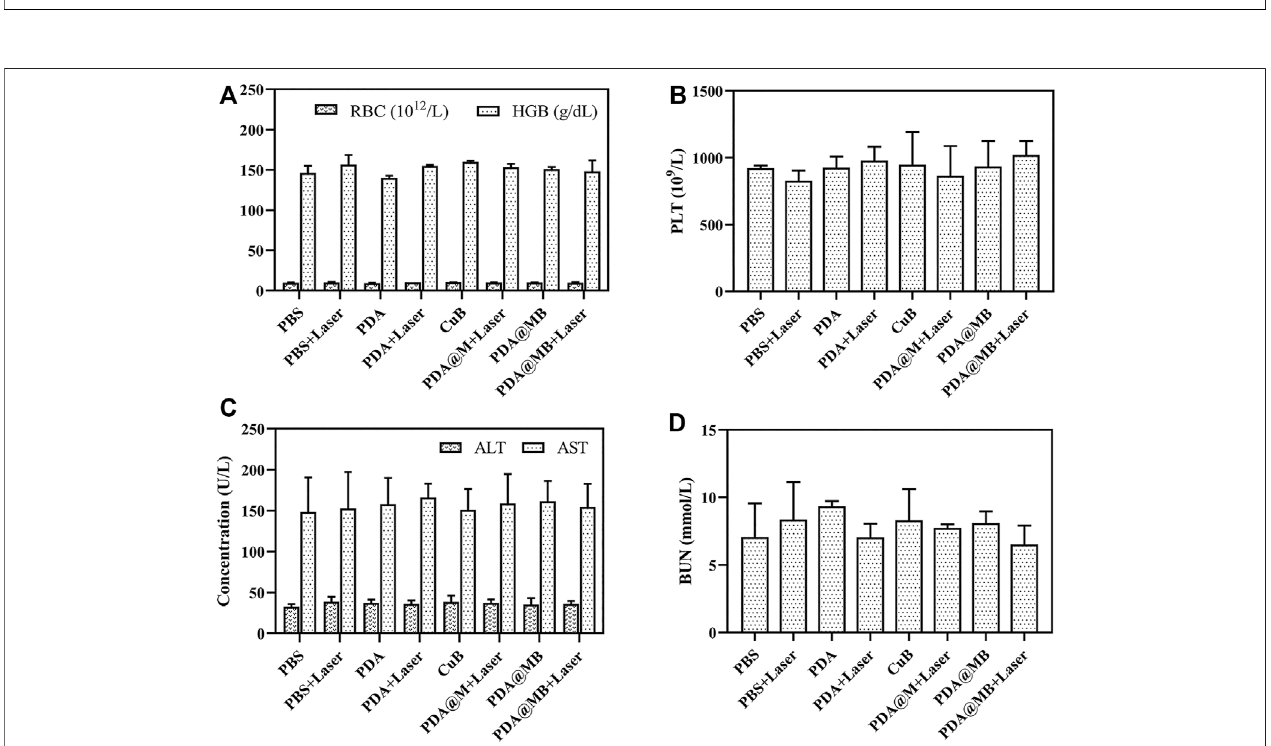
FIGURE7|(A) Redbloodcell(RBC)andhemoglobin(HGB),and (B) platelets(PLT)ofbloodroutineexamination. (C) Alanineaminotransferase(ALT)andaspartate aminotransferase (AST), and (D) blood urea nitrogen (BUN) of blood biochemistry test.